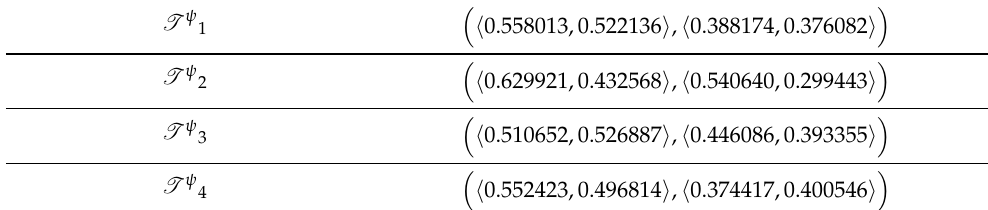
Table 10. Aggregated weighted LDF decision